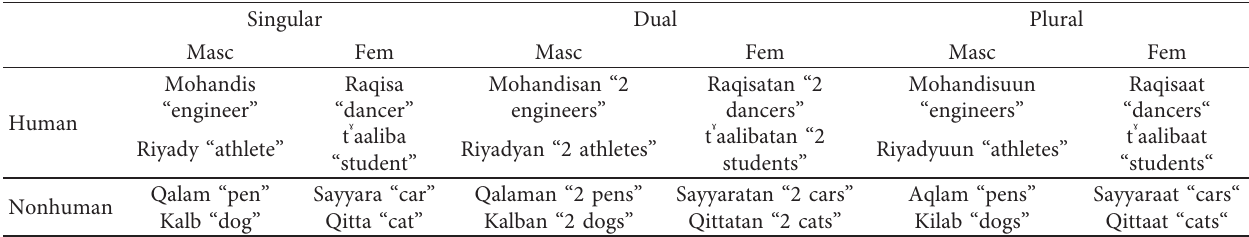
Table 1: Sample elicited production task items by gender and number from vocabulary set 1.